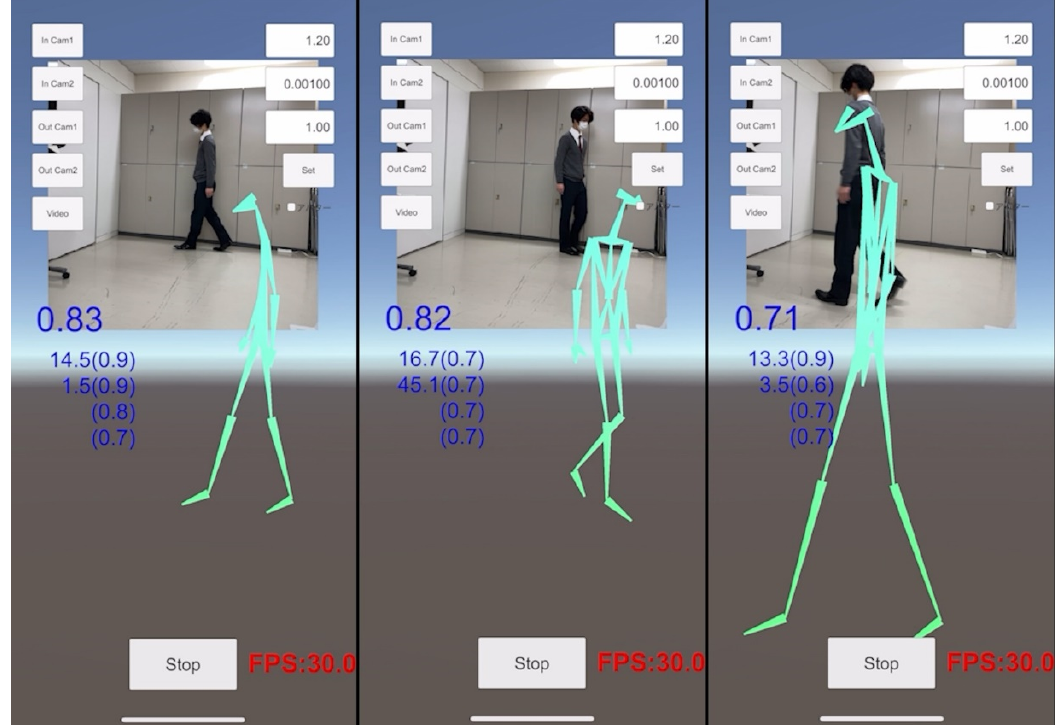
Figure 4. Snapshots of the TDPT for Gait Test (TDPT-GT) application and calculated 3D joint angles and artificial intelligence (AI) scores, also called the confidence scores in a healthy young volunteer. The iPhone was fixed as horizontal as possible to the floor. The entire body of the subject from the head to the toes must always be in the videoframe. The blue-colored number at the left of the videoframe shows the reliability of the position information of the entire body as an AI score, and the small numbers below show the 3D angles (AI scores) of the left and right knee joints, and (AI scores) of the left and right ankle joints.